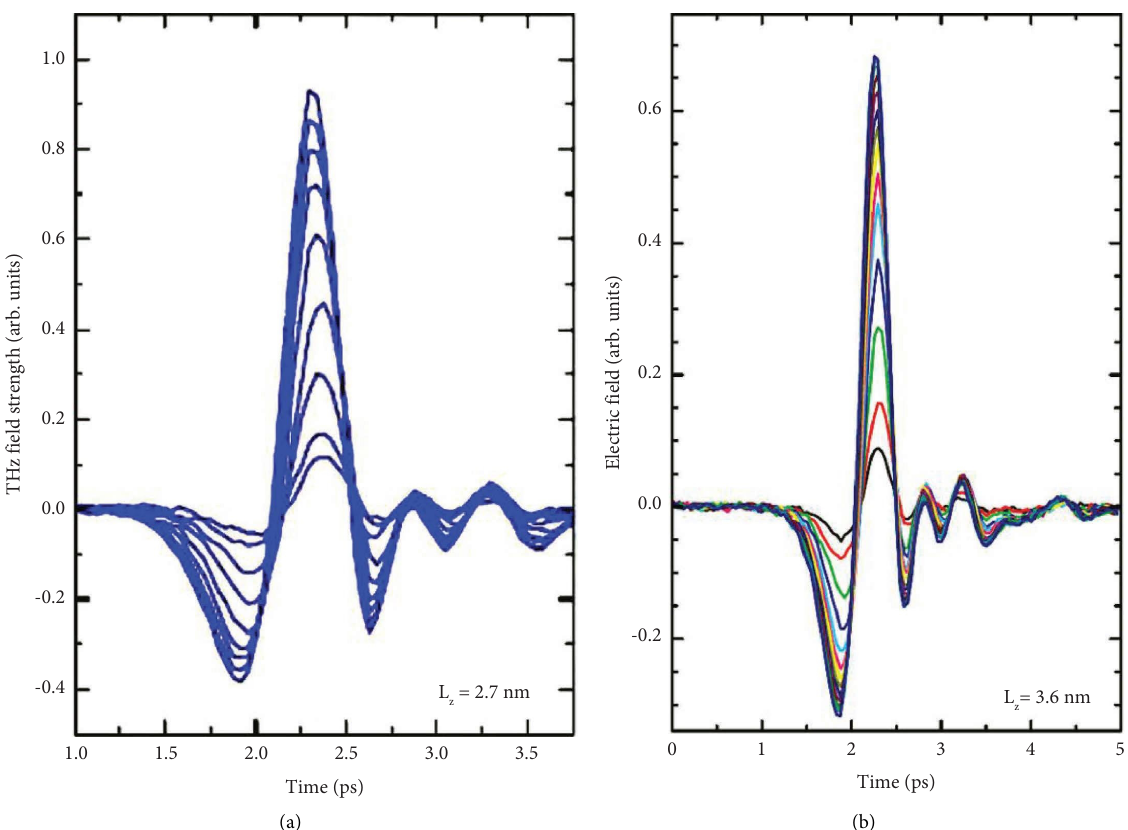
Figure 4: (a) THz pulses detected from samples with 2.7 nm and (b) 3.6 nm QW widths for varying pump fuences. Reproduced with permission from the American Physical Society. Copyright American Physical